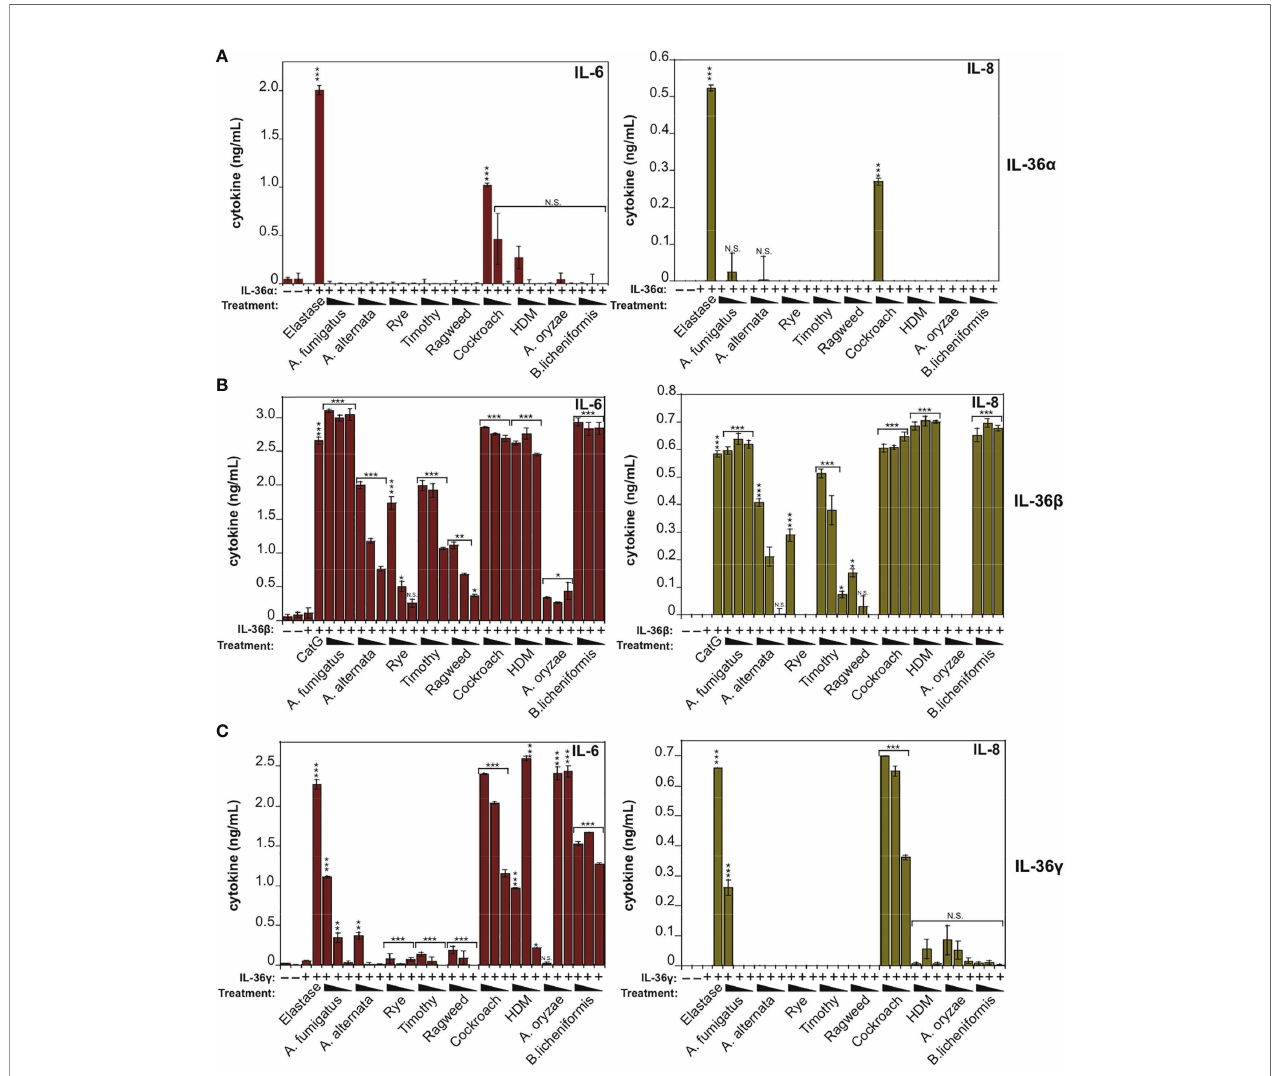
FIGURE 3 | IL-36 b is particularly susceptible to activation in response to multiple allergen-associated proteases (A) HeLa IL-36R cells were stimulated with full-length human IL-36 a (2 nM), either untreated, or after incubation for 2 h at 37°C with the indicated allergen extracts. All allergens were titrated over a concentration range of 20, 10 and 5 m g/ml, with the exception of puri fi ed protease from A. oryzae , which was used at dilutions of 1:250, 1:500 or 1:1000 of concentrated stock. As a positive control, IL-36 a was activated with elastase (20 nM). After 24 h, IL-6 and IL-8 cytokines in cell culture supernatants were measured by ELISA. (B) HeLa IL-36R cells were stimulated with full-length human IL-36 b (2 nM), either untreated, or after incubation for 2 h at 37 °C with the indicated allergen extracts, as described above. As a positive control, IL-36 b was activated with cathepsin G (20 nM). After 24 h, IL-6 and IL-8 cytokines in cell culture supernatants were measured by ELISA. (C) HeLa IL-36R cells were stimulated with full-length human IL-36 g (2 nM), either untreated, or after incubation for 2 h at 37°C with the indicated allergen extracts, as described in (A) . As a positive control, IL-36 g was activated with elastase (20 nM). After 24 h, IL-6 and IL-8 cytokines in cell culture supernatants were measured by ELISA. Error bars represent the mean of triplicate determinations from representative experiments. ***p < 0.001, **p < 0.01, *p < 0.1, Student ’ s t test. N.S., Not Signi fi